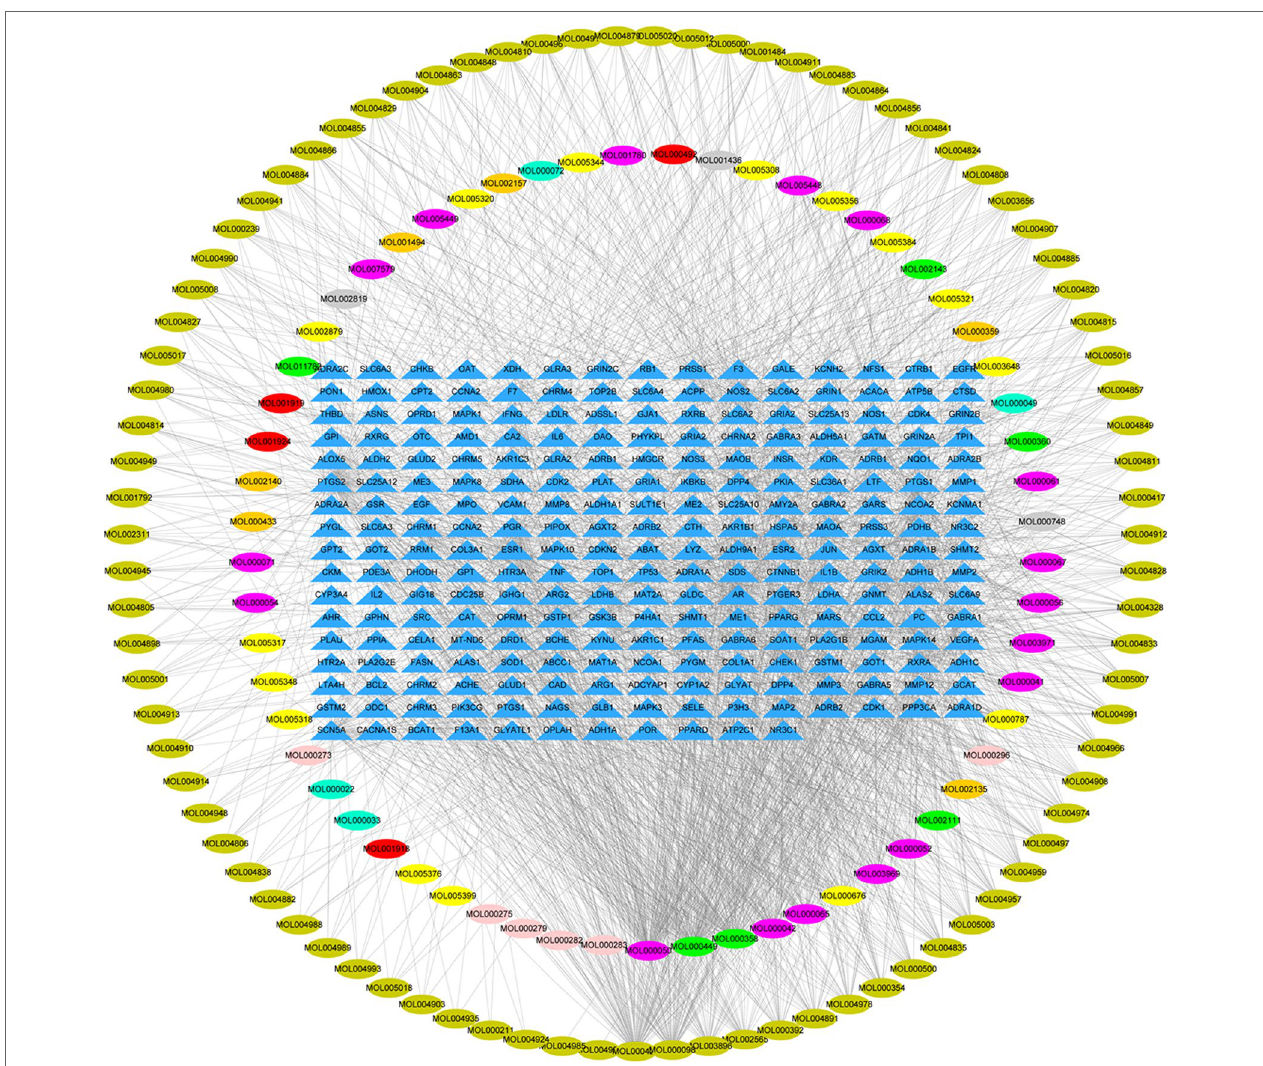
FIgUrE 2 | Compound- target network of YQSX. The blue triangles represent targets; the yellow, pink, cyan, kelly green, green, orange, red, gray, and violet ovals represent the compounds from GRR, P, AMR, RRG, ASR, CR, PRA, RRP, and ACC, respectively.